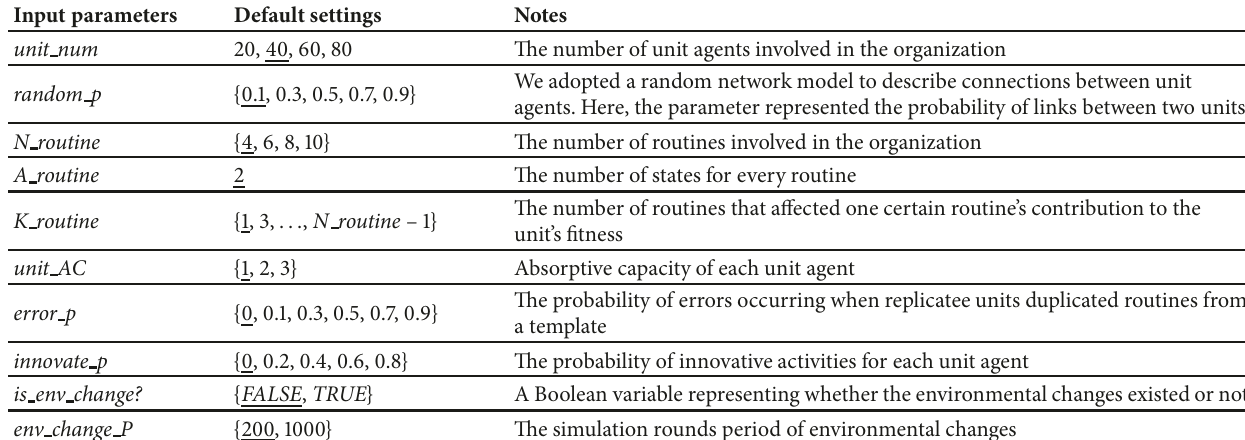
Table 2: Model input settings.